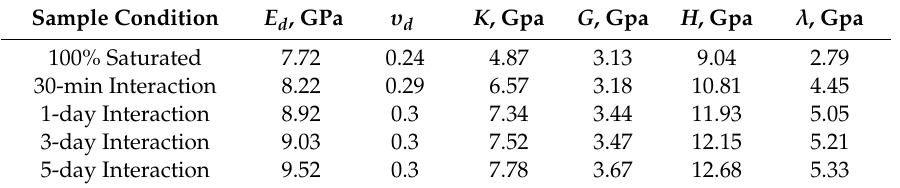
Table 5. Summary of the geomechanical elastic moduli with the exposure time. Table 6. Dynamic elastic moduli as a function of exposure time.